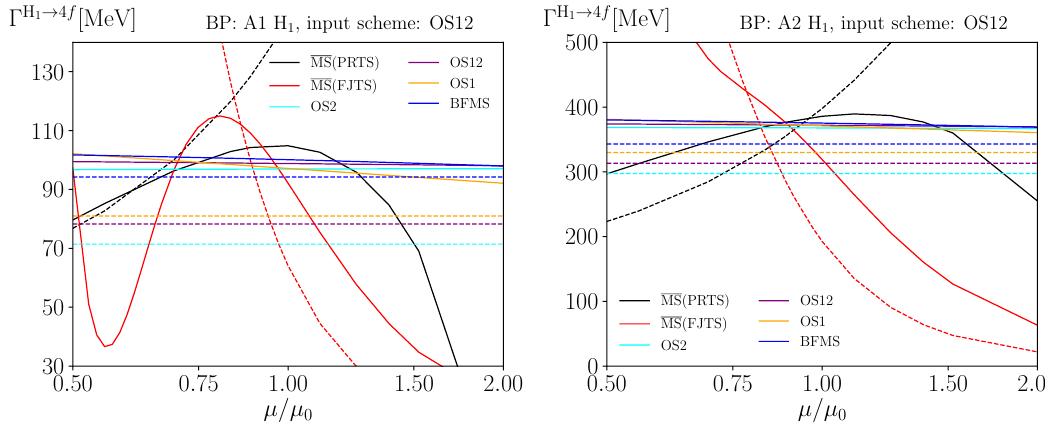
Figure 3 . As in (cid:12)gure 2, but for the decay width (cid:0) H 1 ! 4 f of the heavy CP-even Higgs boson of the